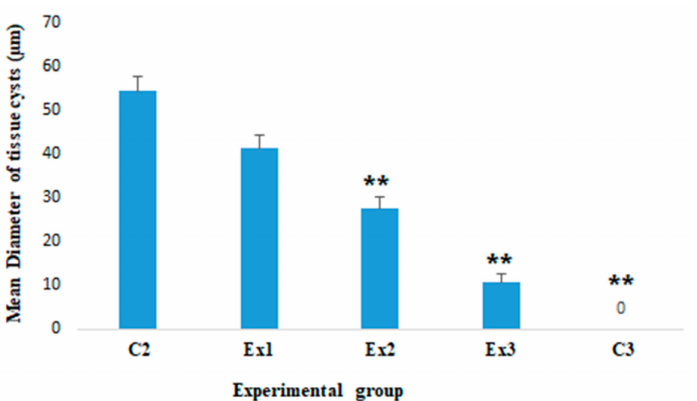
Figure 2. The mean diameter of brain tissue cysts in mice of tested group. The mean diameter of tissue cysts in experimental group C2 was 57.4 ± 3.35 µ m, although this value was 43.5 ± 2.96 µ m in mice of experimental group Ex1 (100 mg/kg); however, the mean diameter of tissue cyst was significantly reduced in mice of experimental groups Ex2 (200 mg/kg) and Ex3 (300 mg/kg). ** p <